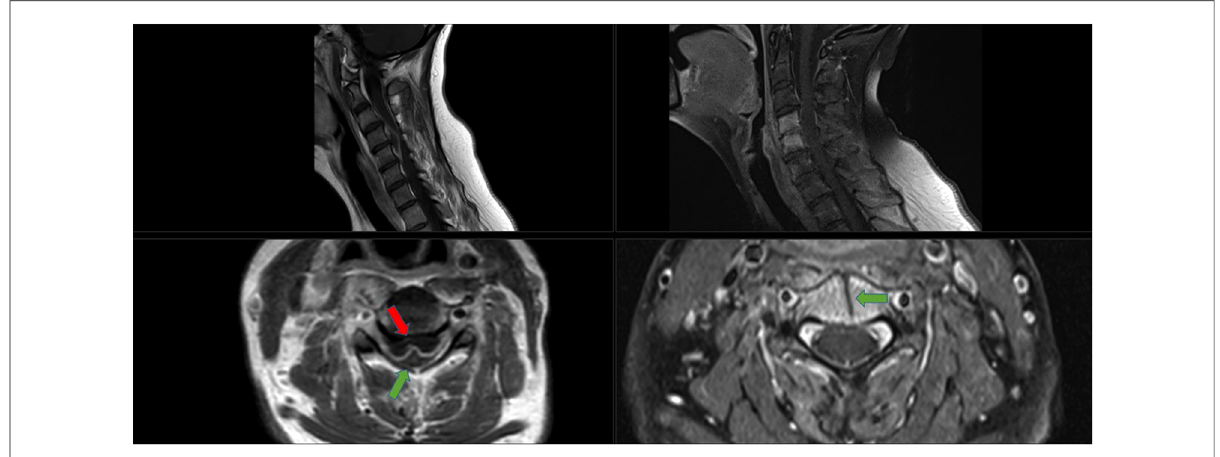
FIGURE 2 Radiological images of case 3. Left images: Pre-operative MRI of the cervical spine (T1-weighted images post-gadolinium infusion, slice thickness 4.0 mm). Upper image shows a sagittal view with a ventral cervical epidural abscess on C4 – 5 with compression of the spinal cord. Lower image shows the axial view, red arrow points to the abscess, green arrow the spinal cord. In between a hyper-intense contrast signal indicating the existence of an abscess capsule. Right images: Post-operative MRI of the cervical spine, 2 weeks post-operative and antibiotic treatment with cefuroxime (T1-weighted images post-gadolinium infusion, slice thickness 3.0 mm). Upper image: Sagittal view with a hyper-intense signal of the vertebral bodies of C4 and C5, but no abscess. Furthermore, the cervical spine is normal alignment; there is no sign of kyphosis or collapse of the vertebral bodies. Lower image: axial view with the green arrow pointing to the anterior transvertebral trench and the spinal cord after adequate decompression and antibiotic